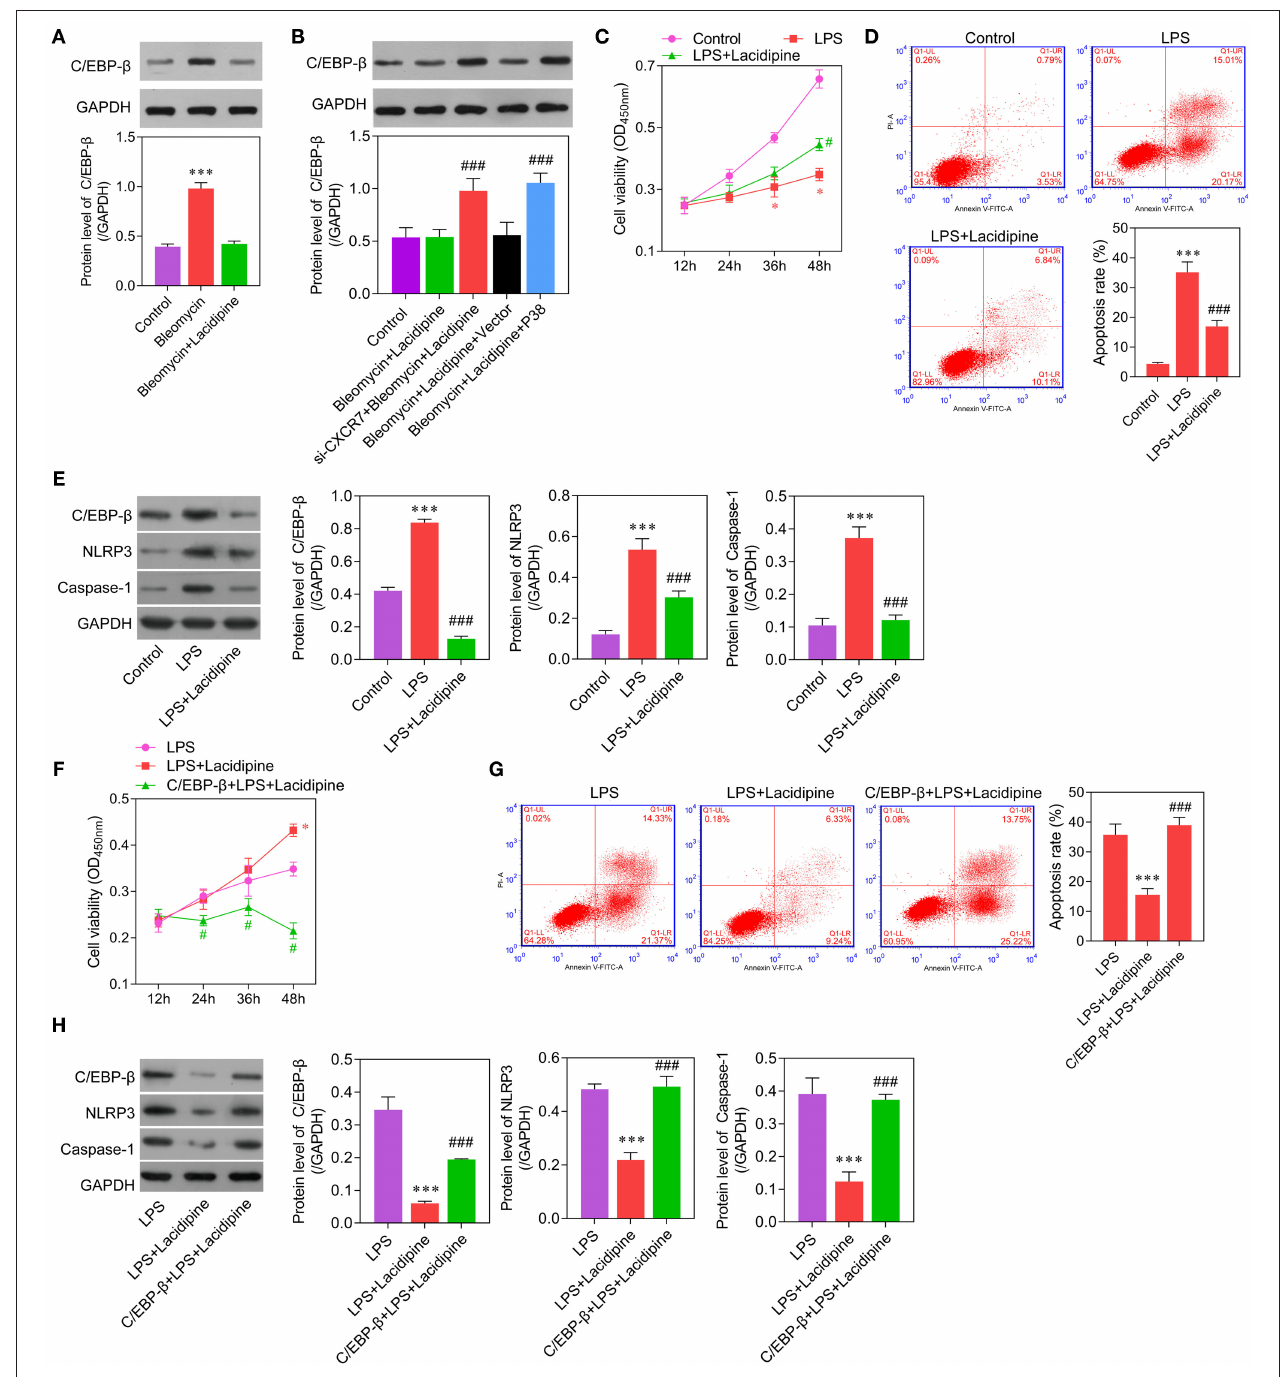
FIGURE 5 | C/EBP- β was involved in Lacidipine-mediated anti-inflammation and anti-apoptosis effects on ECs. Cultured ECs were treated with Lacidipine, followed by bleomycin stimulation. Western blot was performed to analyze the level of C/EBP- β (A,B) . (*** p < 0.001, compared with the bleomycin + Lacidipine group; ### p < 0.001, compared with the bleomycin + Lacidipine + Vector group). To further study the inflammatory activation, ECs were treated with Lacidipine, followed by LPS stimulation. Cell viability was determined using CCK-8 assay in ECs from the control, LPS, and LPS + Lacidipine groups (C) . Apoptotic cells were determined by flow cytometry in ECs from the control, LPS, and LPS + Lacidipine groups (D) . The protein expression of C/EBP- β , NLRP3, and caspase-1 was detected by Western blot in ECs from the control, LPS, and LPS + Lacidipine groups (E) . (Data are mean ± SD of three independent experiments. * p < 0.05, *** p < 0.001, compared with the control group; # p < 0.05, ### p < 0.001, compared with the LPS group). Cell viability was determined using CCK-8 assay in ECs from the LPS, LPS + Lacidipine, and C/EBP- β + LPS + Lacidipine groups (F) . Apoptotic cells were determined by flow cytometry in ECs from the LPS, LPS + Lacidipine, and C/EBP- β + LPS + Lacidipine groups (G) . The protein expression of C/EBP- β , NLRP3, and caspase-1 was detected by Western blot in ECs from the LPS, LPS + Lacidipine, and C/EBP- β + LPS + Lacidipine groups (H) . (Data are mean ± SD of three independent experiments. * p < 0.05, *** p < 0.001, compared with the LPS group; # p < 0.05, ### p < 0.001, compared with the LPS + Lacidipine group).